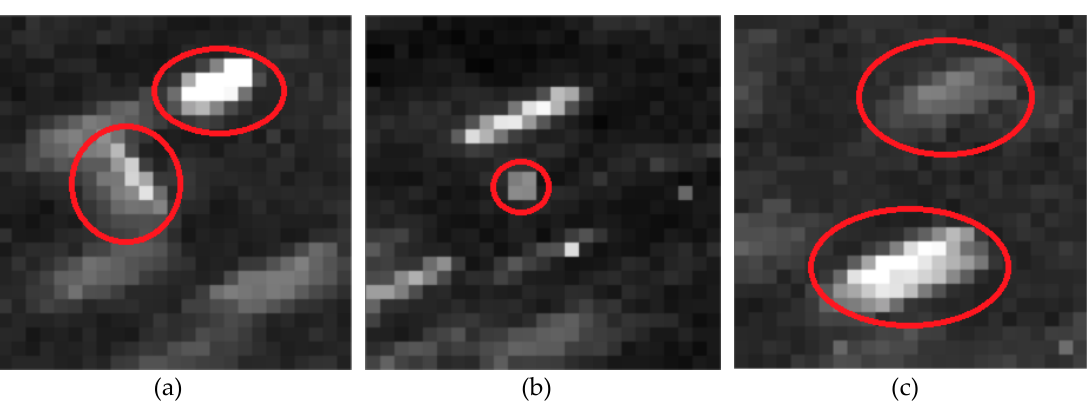
Figure 1. Composition of charge coupled device (CCD) star image besides background: ( a ) non- geostationary earth orbit (GEO) debris; ( b ) GEO debris; ( c ) stars.